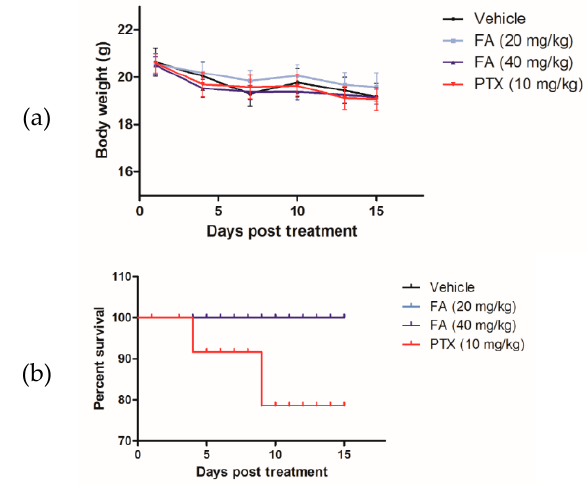
Figure 10. The toxicity of FA and PTX was assessed in terms of ( a ) the body weight of mice and ( b ) the survival rate of animals during the course of experimental period.